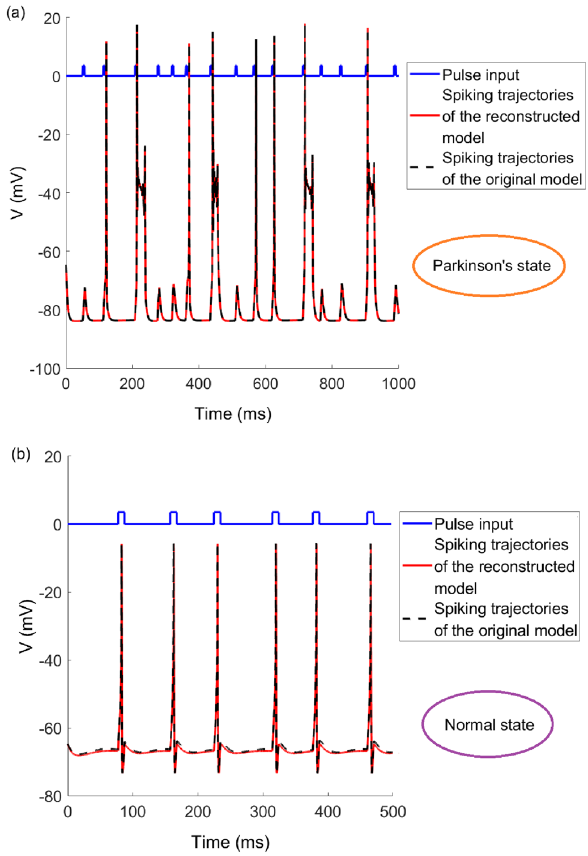
Figure 6. The spiking trajectories of the TC model with given parameters and the reconstructed TC model with fitted parameters in ( a ) Parkinson’s state ( b ) normal state under Poisson input. The black curves represent the spiking trajectories of the original model with given parameters, and the red curves represent the spiking trajectories of the reconstructed model. The blue curves are the Poisson pulse